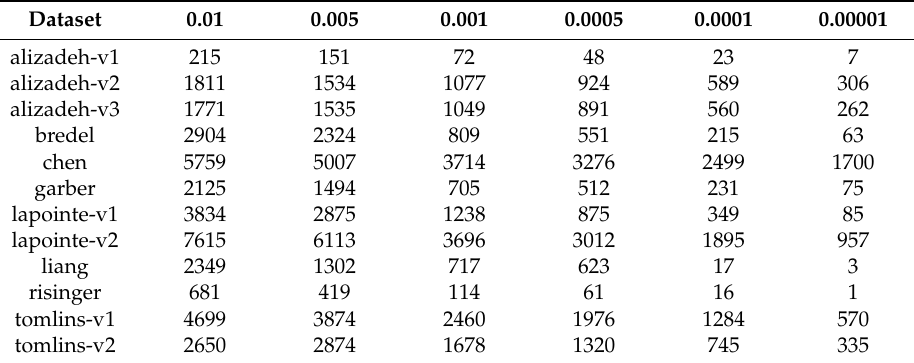
Table 1. Number of selected genes with respect to different thresholds.